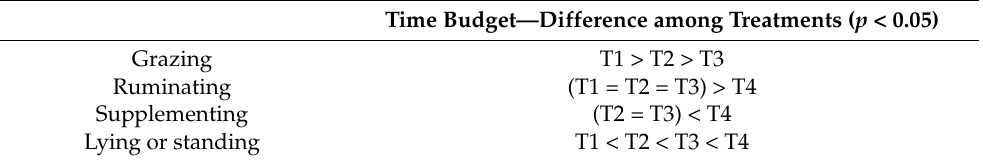
Figure 7. Treatment classification based on behavior frequency distribution. LorS: lying or standing. Table 2. Time budget associated with each behavior (differences among treatments). Time Budget—Difference among Treatments ( p < 0.05)